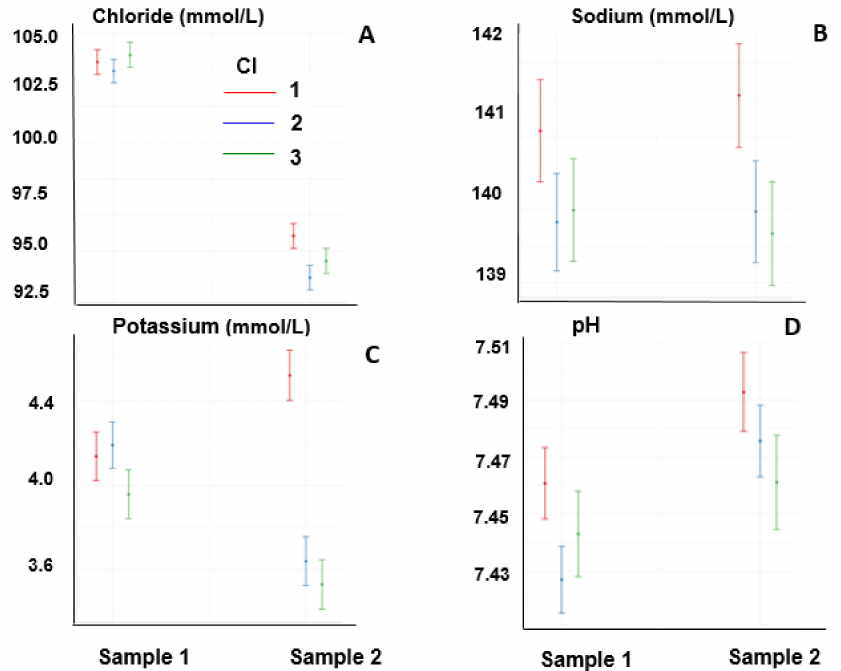
Figure 4. Chloride ( A ), sodium ( B ), and potassium ( C ) concentrations, and pH ( D ) of horses one day before the race (Sample 1) and at elimination or when they retired from the race (Sample